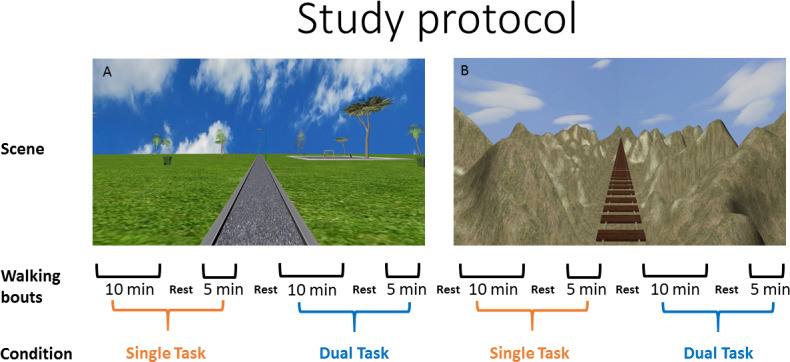
Study protocol.The protocol consisted of walking trials in two different scenes, park (A) and a no-hands hanging bridge (B). Each scene was used in four walking trials of single-task and dual-task conditions in walking bouts of ten and five minutes with rest between walking trails. Participants performed eight walking trails, with the exception of one young and five older participants who asked to stop. The order of the scenes and the conditions were randomized across participants.